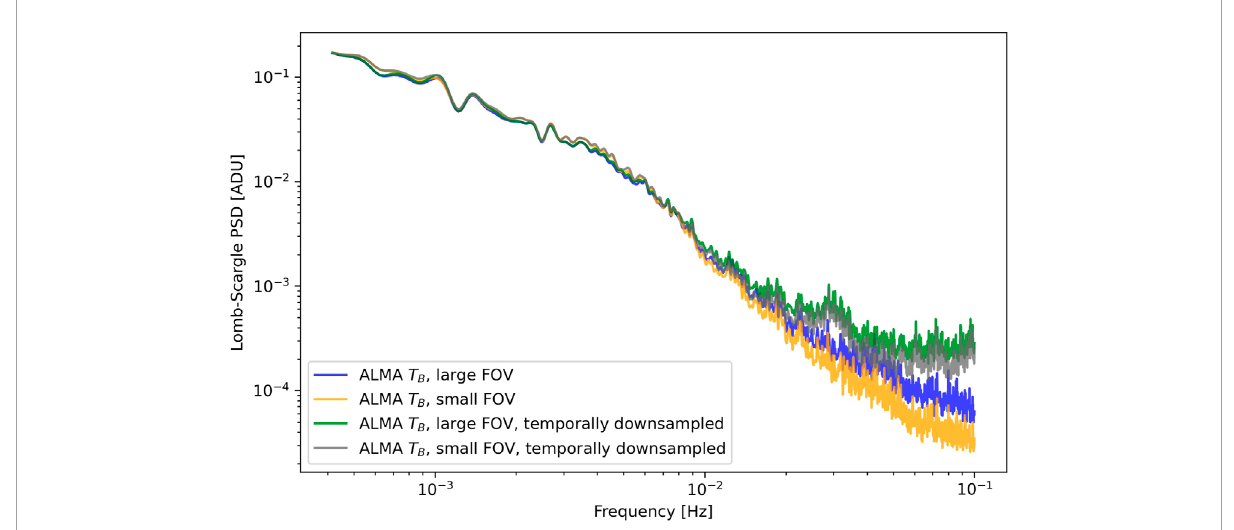
FIGURE 6 Spatially averaged power spectra for different sub-samples of data series. ALMA temperature, large 67 ′′ FOV (blue); ALMA temperature, small 45 ′′ FOV (orange); ALMA temperature large FOV, { t O } (green); ALMA temperature small FOV, { t O } (grey).